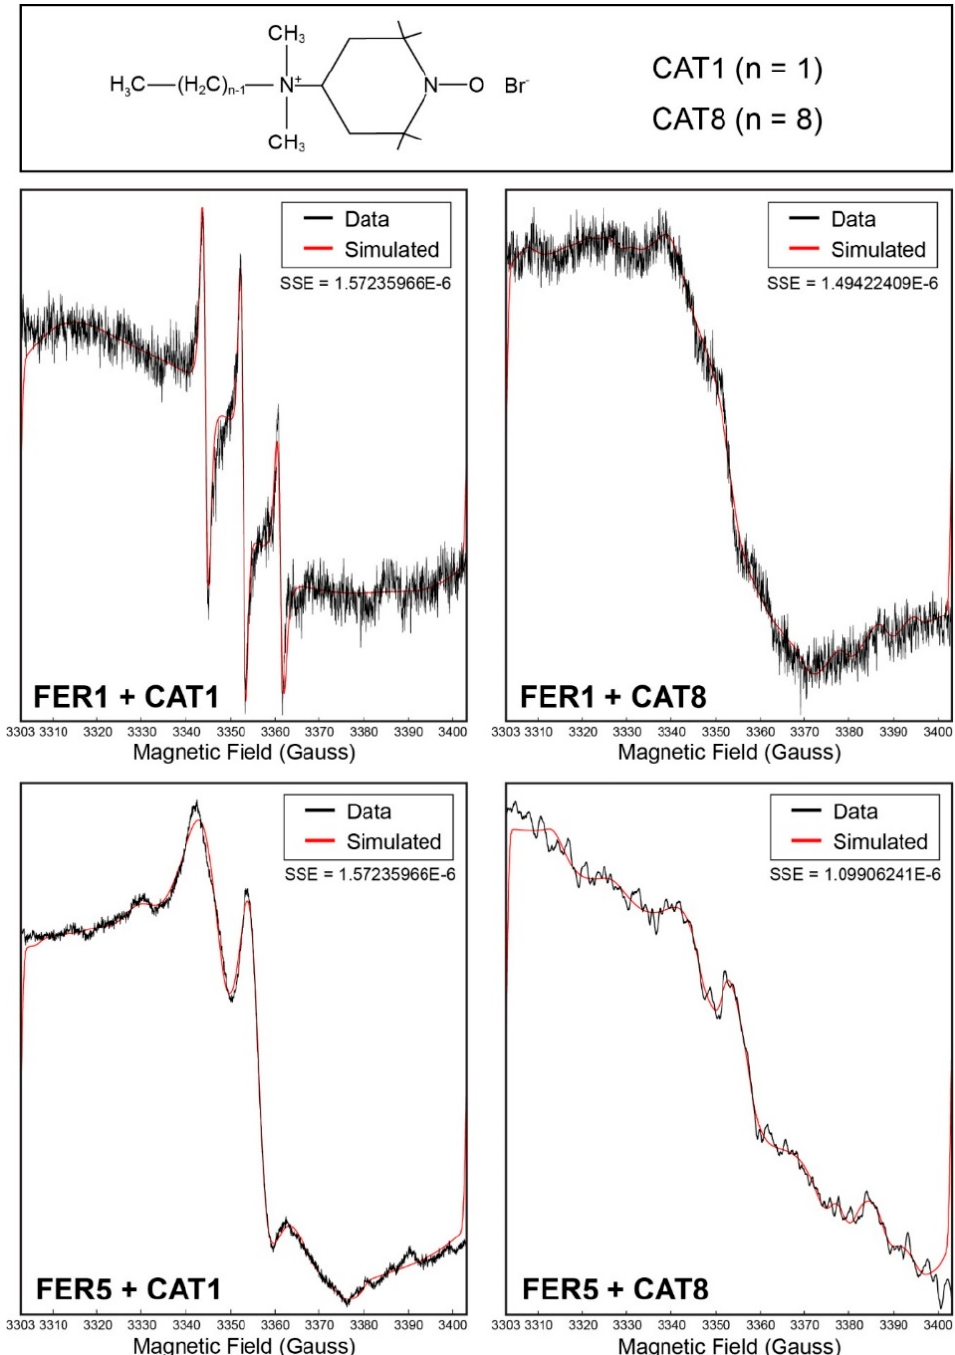
Figure 7. EPR spectral simulation of CAT1 and CAT8 probes adsorbed in FER1 and FER5 samples. Formula for CAT1 and CAT8 probes is shown at the top of the figure. SSE = sum of squares error.